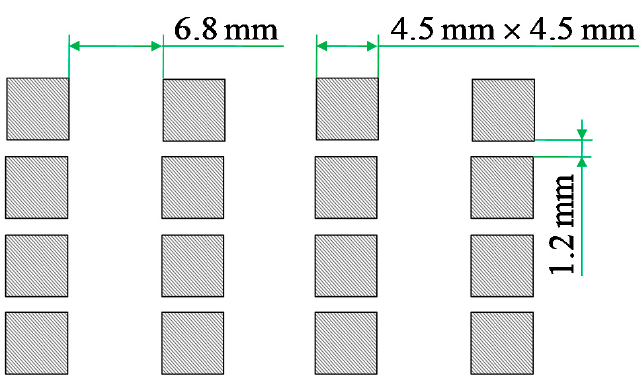
Figure 3. Dimensions of the horizontal sodium channel array.